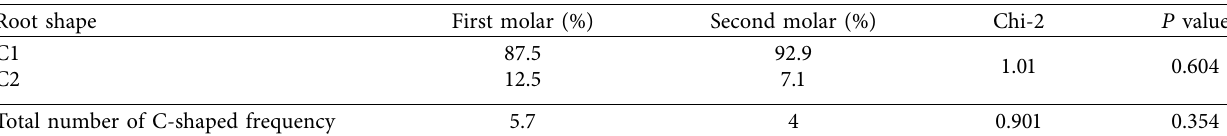
Figure 5: A bar chart showing the percentage of each type of root canal configurations in mesial and distal roots of mandibular first and second molars. Table 5: The frequency of C-shaped